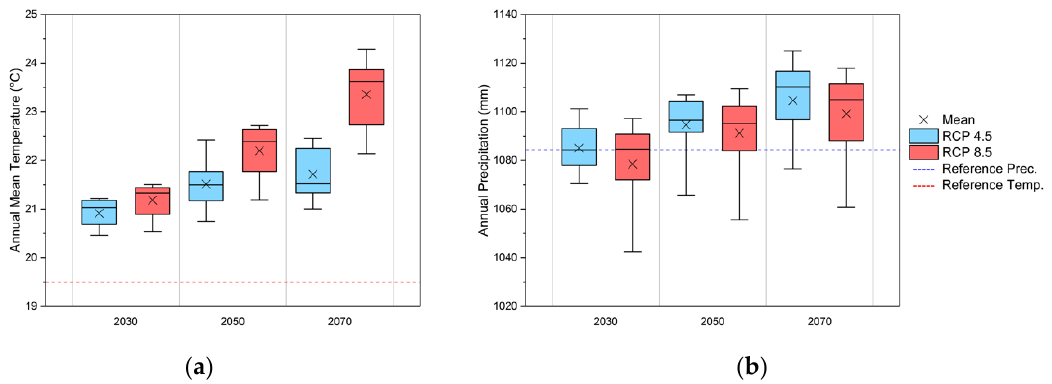
Figure 1. Annual mean temperature ( a ) and annual precipitation ( b ) in Nabanhe Reserve for two Relative Concentration Pathways (RCP 4.5 and RCP 8.5 of IPCC5) derived from 9 General Circulation Models (GCMs) for the time slices of 2030 (20-year average from 2020–2040), 2050 (20-year average from 2040–2060) and 2070 (20-year average from 2060–2080). Boxes and whiskers show the 25/75 and 10/90 percentiles respectively. Lines in boxes show the ensemble median, whereas crosses show the ensemble mean. The dotted lines show long term annual average precipitation and long term annual mean temperature used as a baseline (WorldClim v1.4. [39,40]).